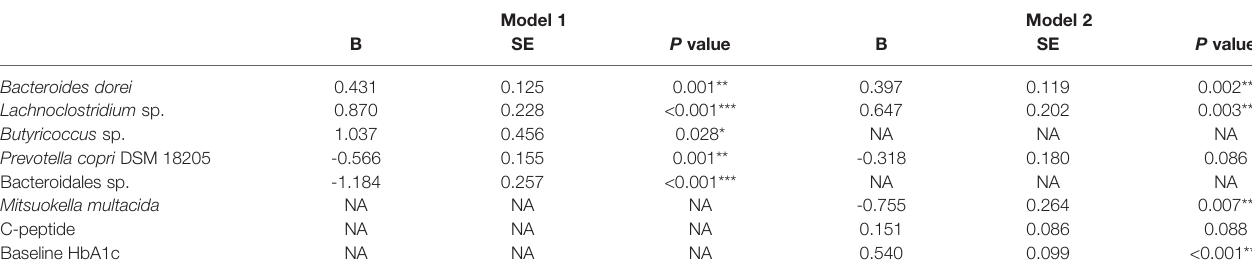
TABLE 2 | Prediction of HbA1c reductions in type 2 diabetic patients receiving GLP-1